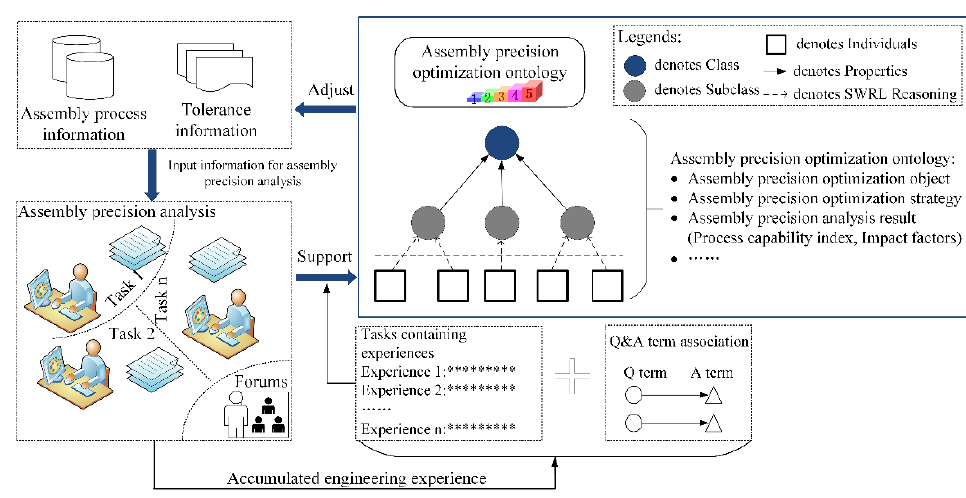
Figure 1. General framework of assembly precision optimization.